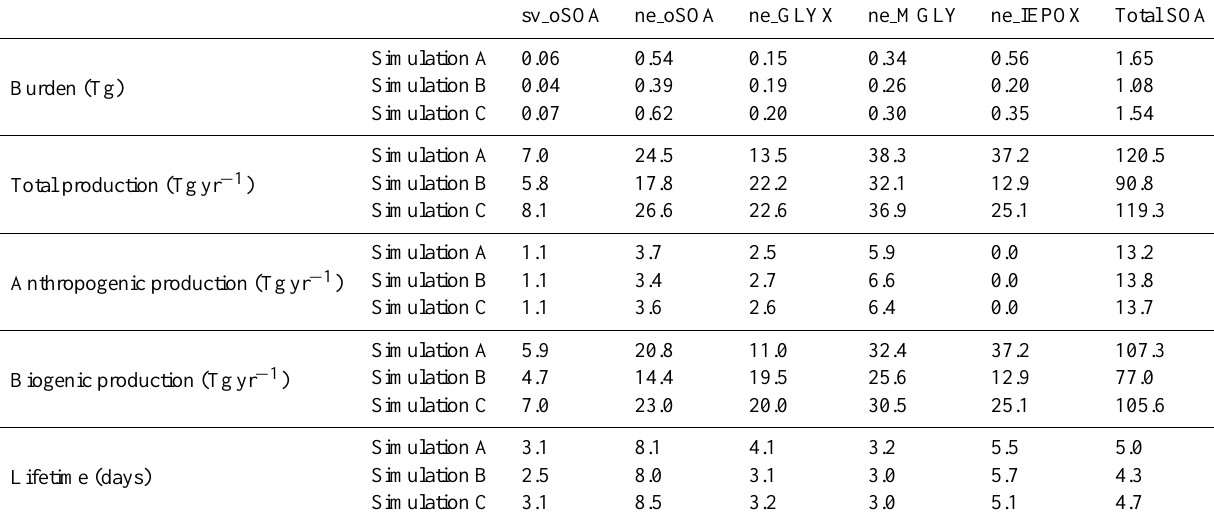
Table 4. The global burden, production and lifetime for each SOA component. sv oSOA ne oSOA ne GLYX ne MGLY ne IEPOX Total SOA Simulation Burden (Tg)